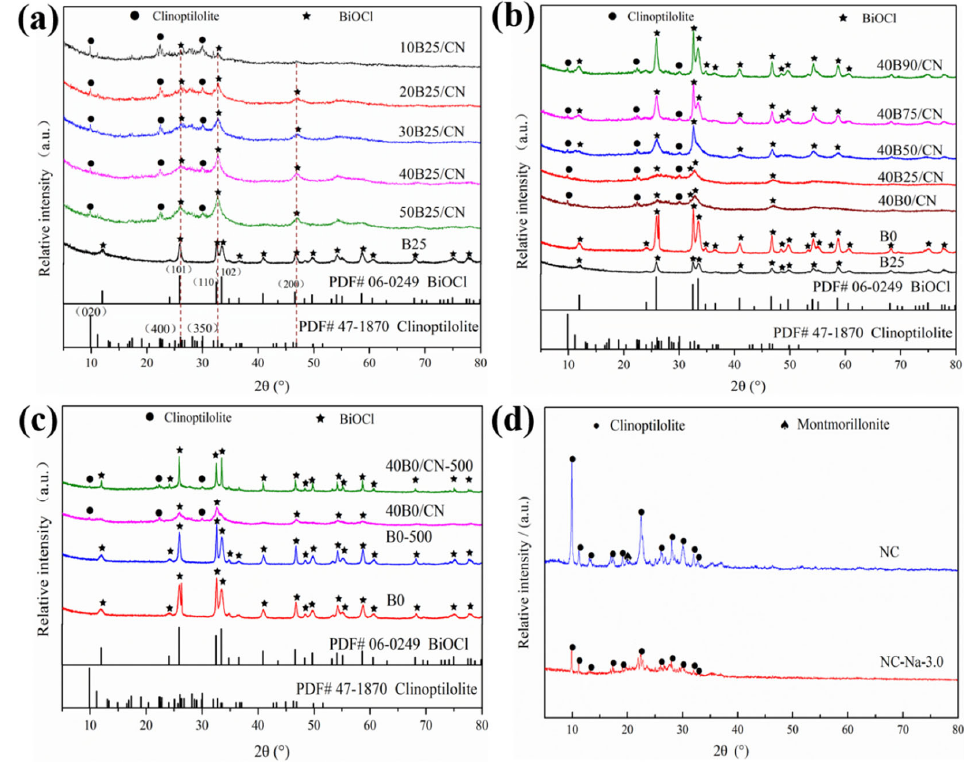
Figure 1. ( a ) XRD spectra of B25 and XBY/CN with different BiOCl loading amounts; ( b ) different reaction temperature; ( c ) XRD spectra of B0 and 40B0/CN before and after calcination; ( d ) XRD spectra of NC and NC ‐ Na ‐ 3.0.